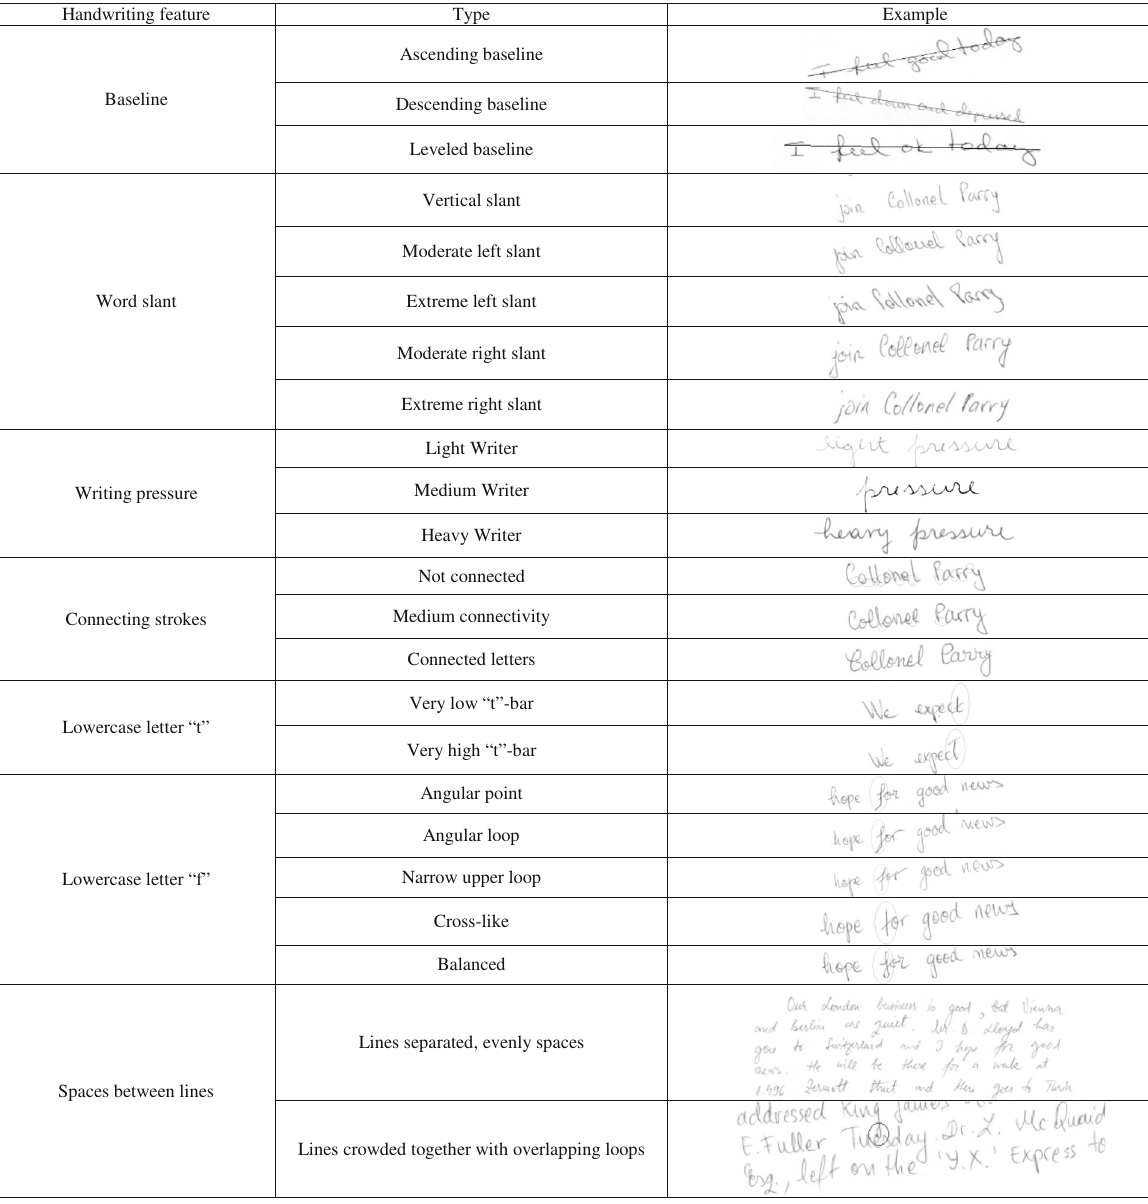
Table 1 Handwriting features and their corresponding types [30] Handwriting